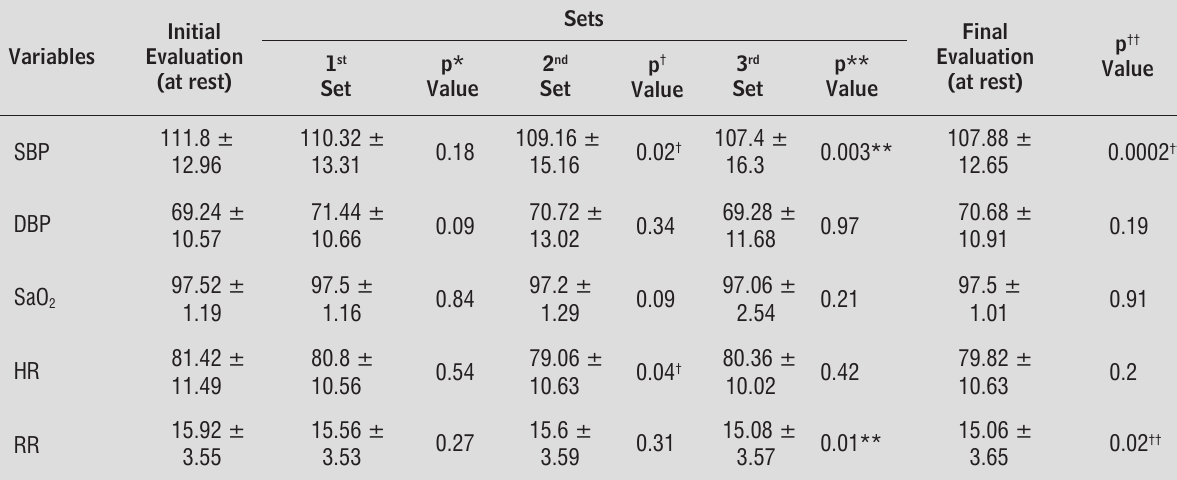
Table 1 - Comparison between the cardiorespiratory variables: initial, final, and during the execution of each of the three sets of ten repetitions –